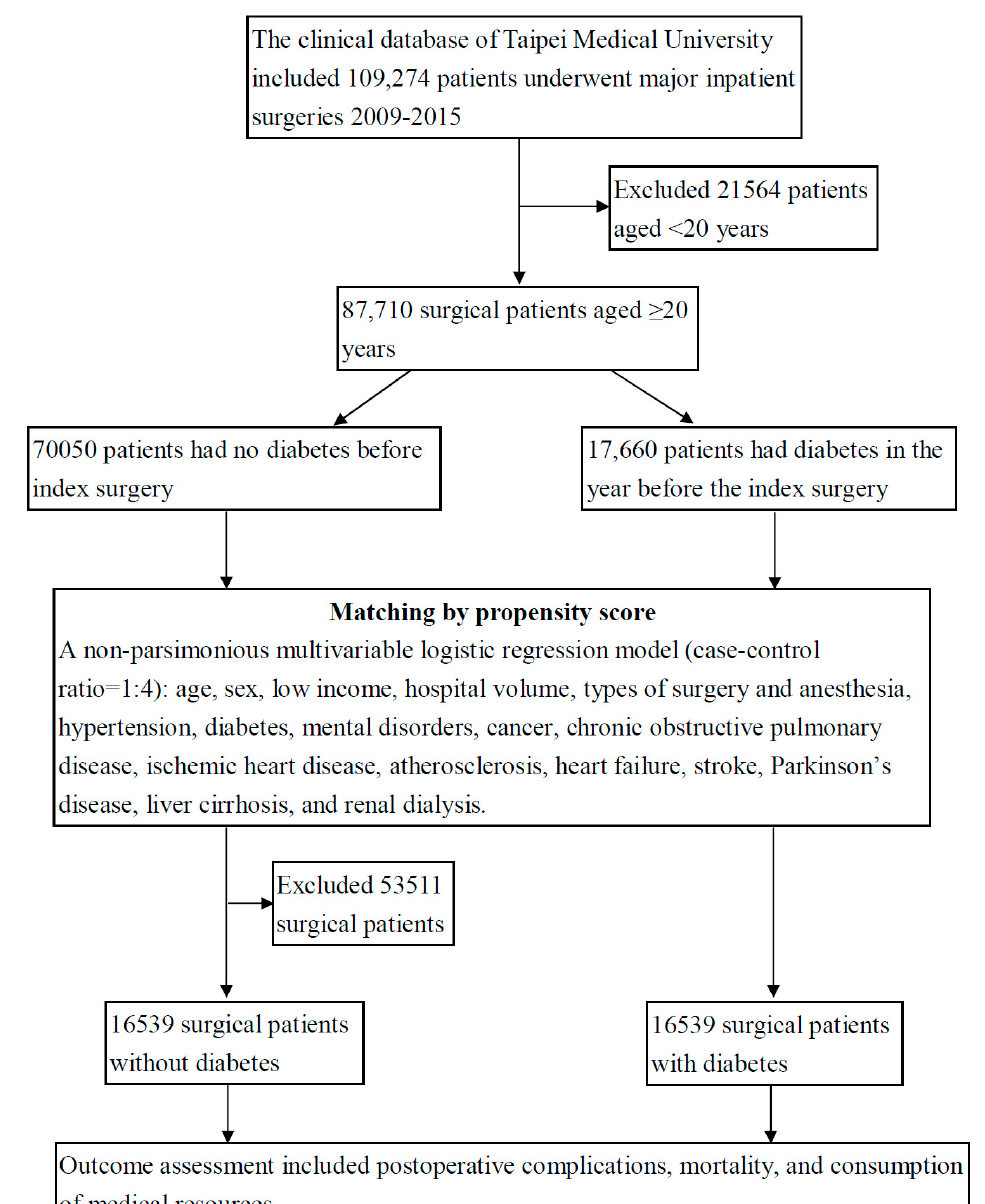
Figure A1. The flowchart of matching by propensity score for patients with diabetes and people without diabetes.